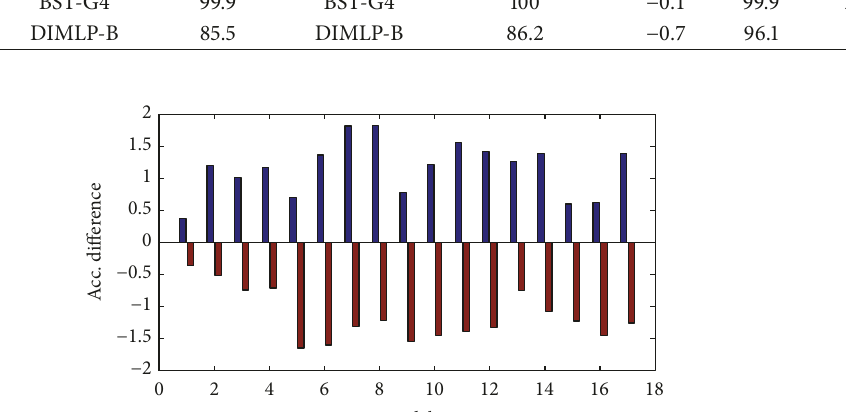
Istanbul Stock Exch.